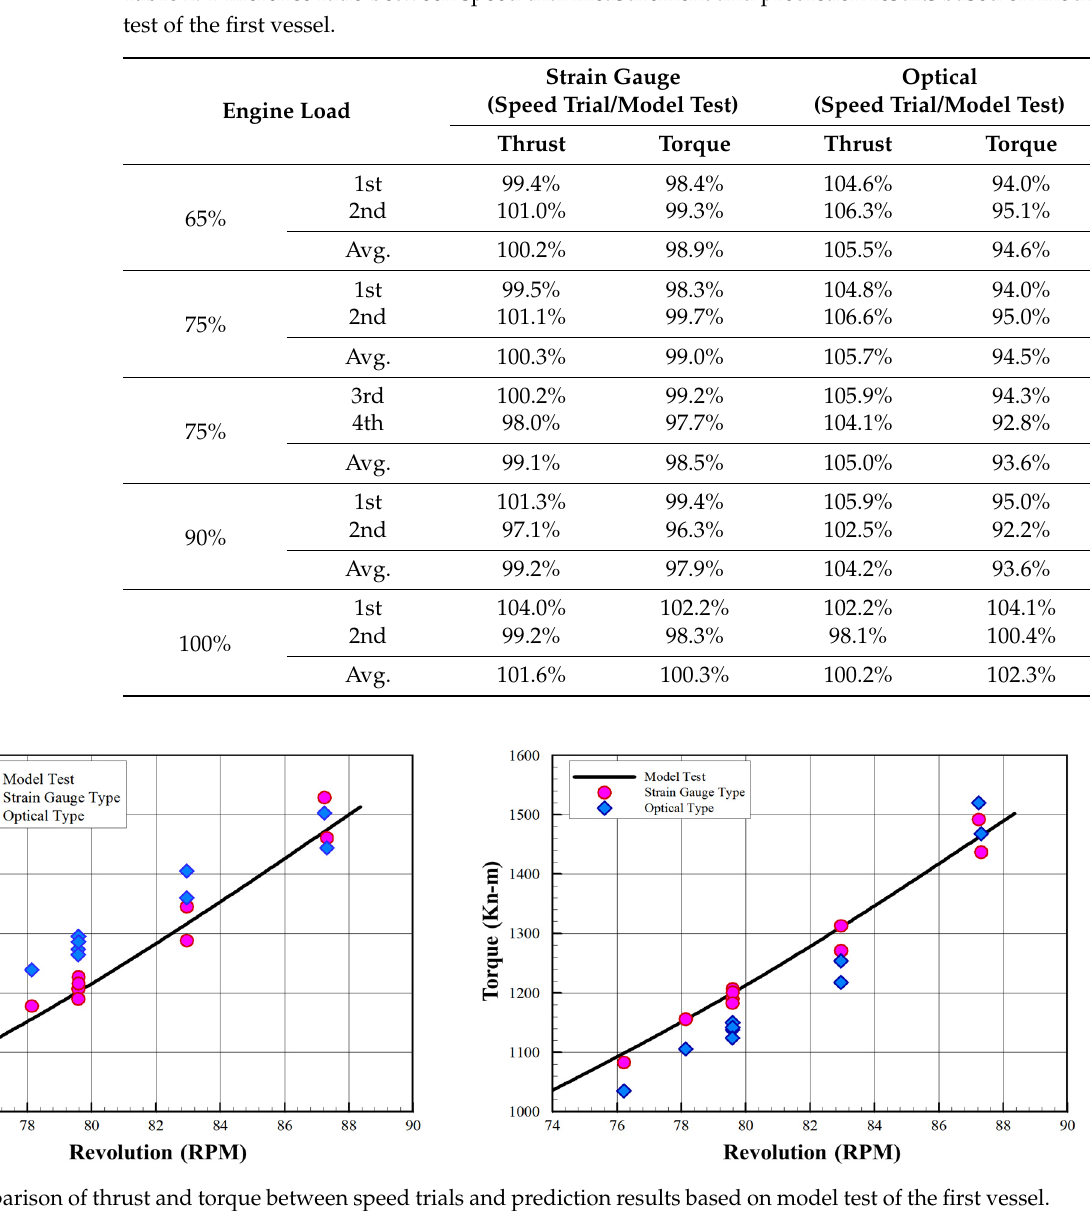
Figure 7. Comparison of thrust and torque between speed trials and prediction results based on model test of the first vessel. Table 3 and Figure 8 show the results of thrust and torque measurements during speed trials of the second vessel compared with prediction results from the model test. Thrust and torque by the strain gauge measurement system are approximately 5% and 3% lower than the prediction results based on model test. In the optical sensor, the results of thrust and torque measurement at the same revolution are approximately 3% and 7% lower than the model test